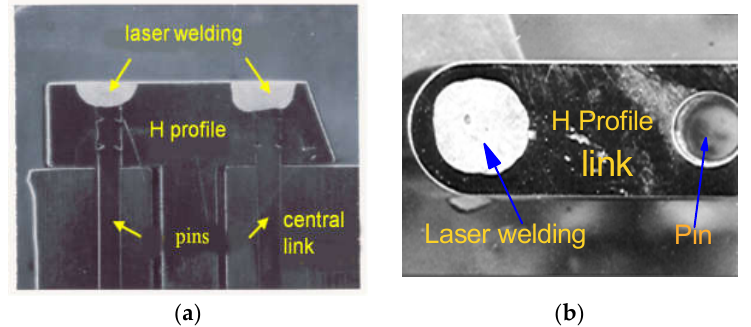
Figure 2. ( a ) Longitudinal link/pin assemblies; ( b ) transverse link/pin assemblies.